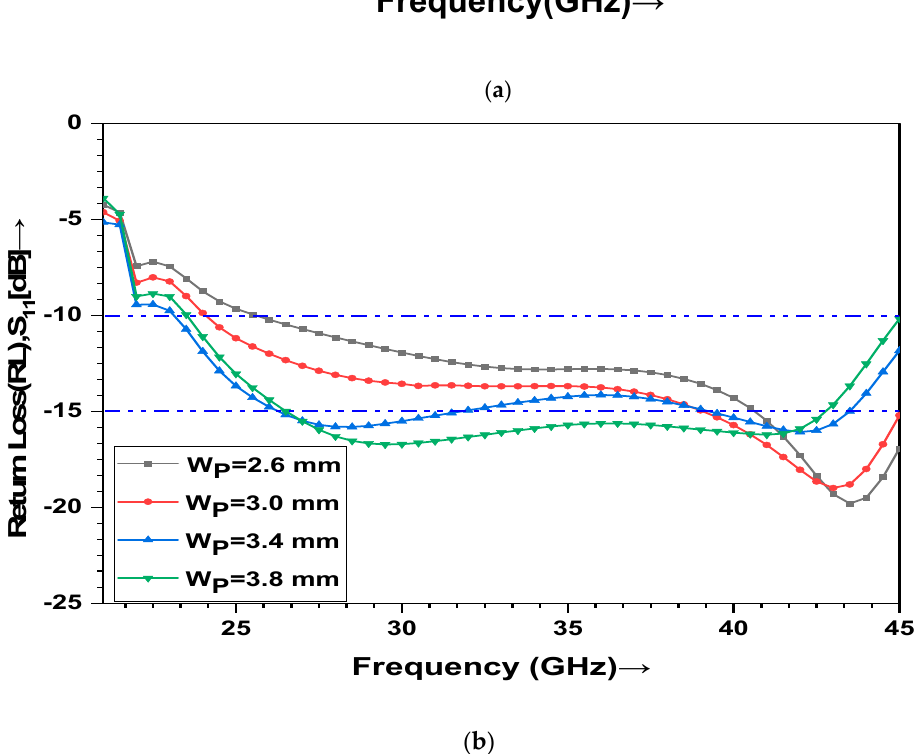
12 (dB) and ( b ) return loss, S 11